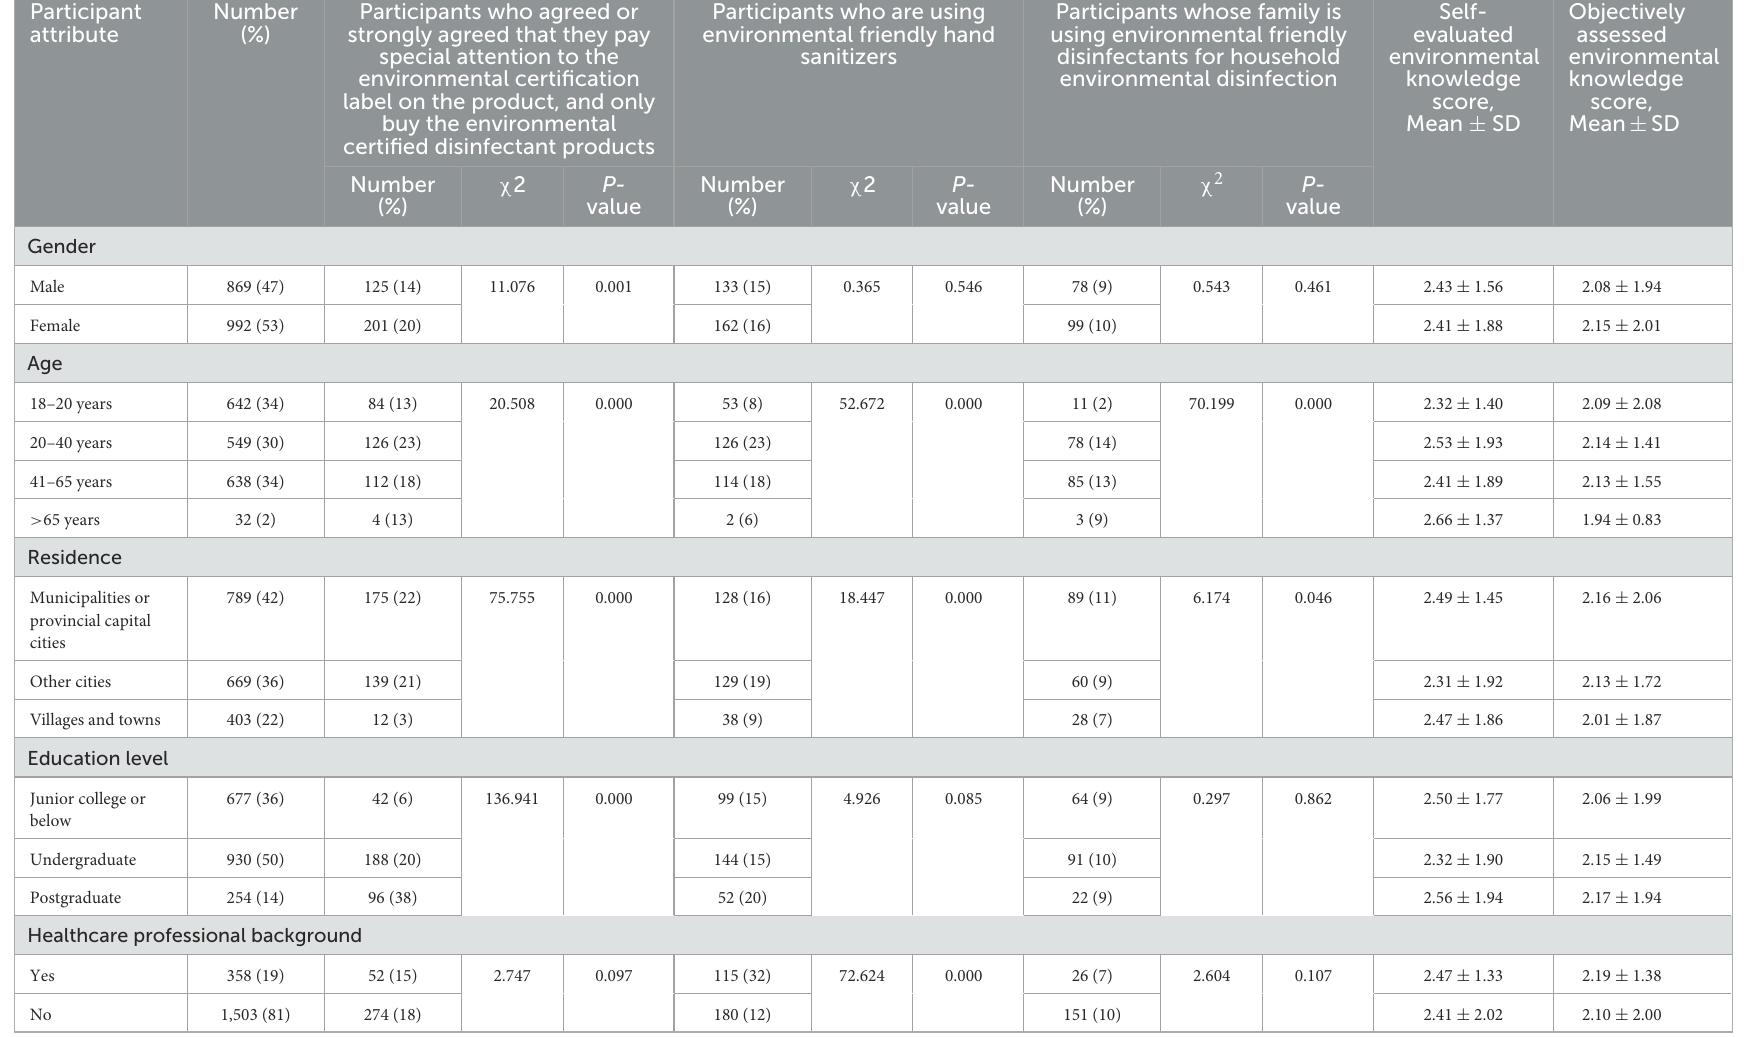
TABLE 1 Demographic information, practice of consuming environmental friendly disinfectants and environmental knowledge regarding disinfectants among participants ( n = 1,861). Participant